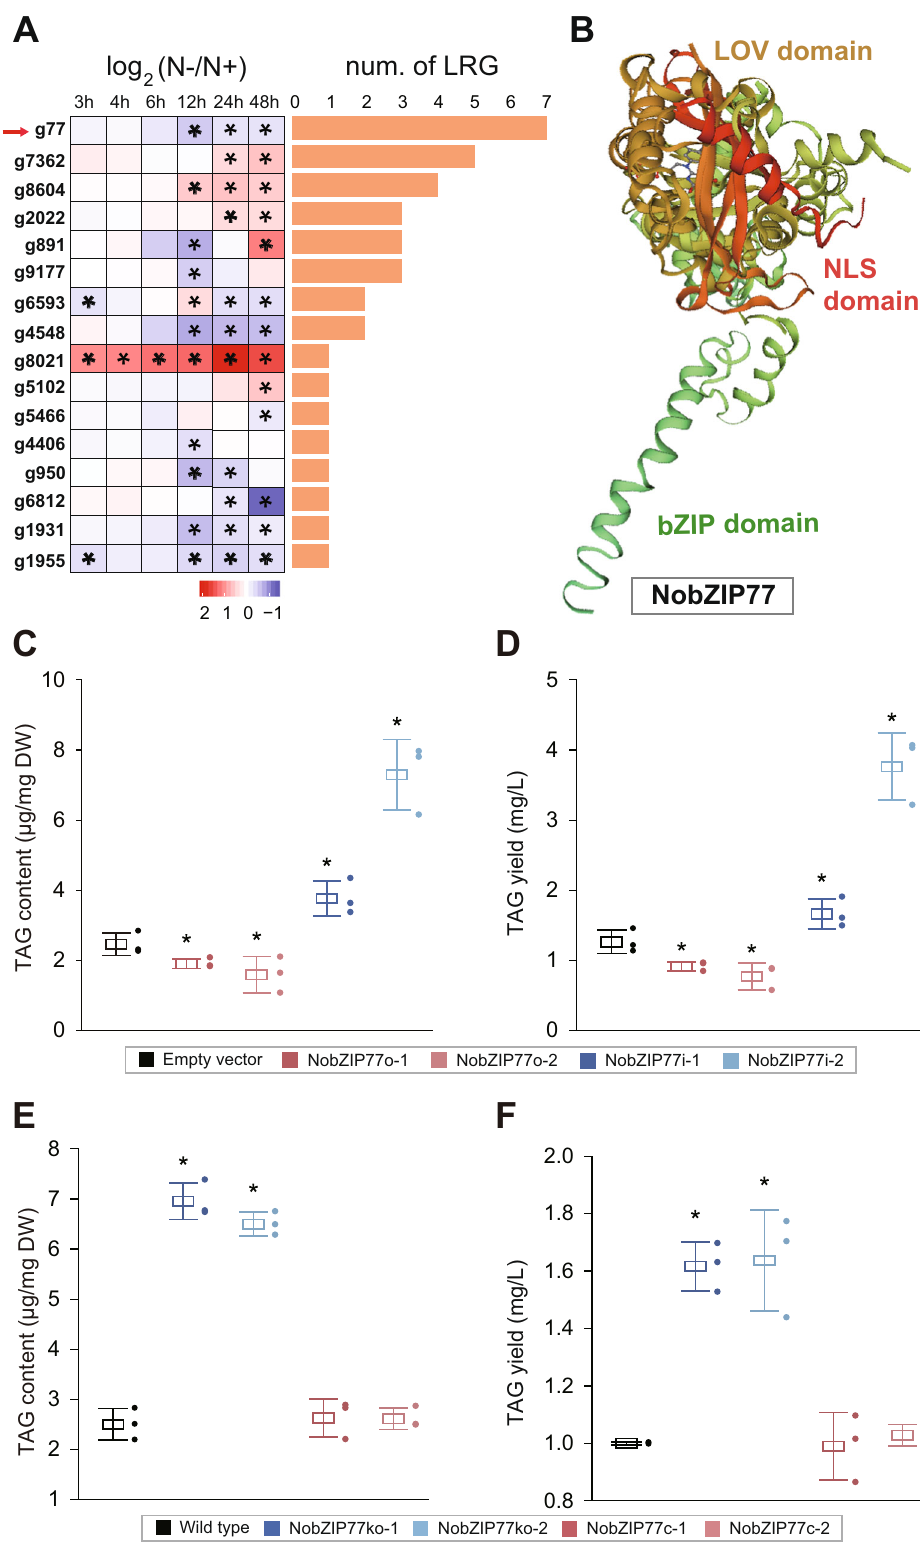
lines under N + (versus WT; Supplementary Fig. 6D). As for TFA content, no difference was found versus WT via knockout, under either N − or N + (Supplementary Fig. 6E). These results indicated that the knockout lines behave similarly as silencing lines. To further pinpoint its in vivo role, NobZIP77 was